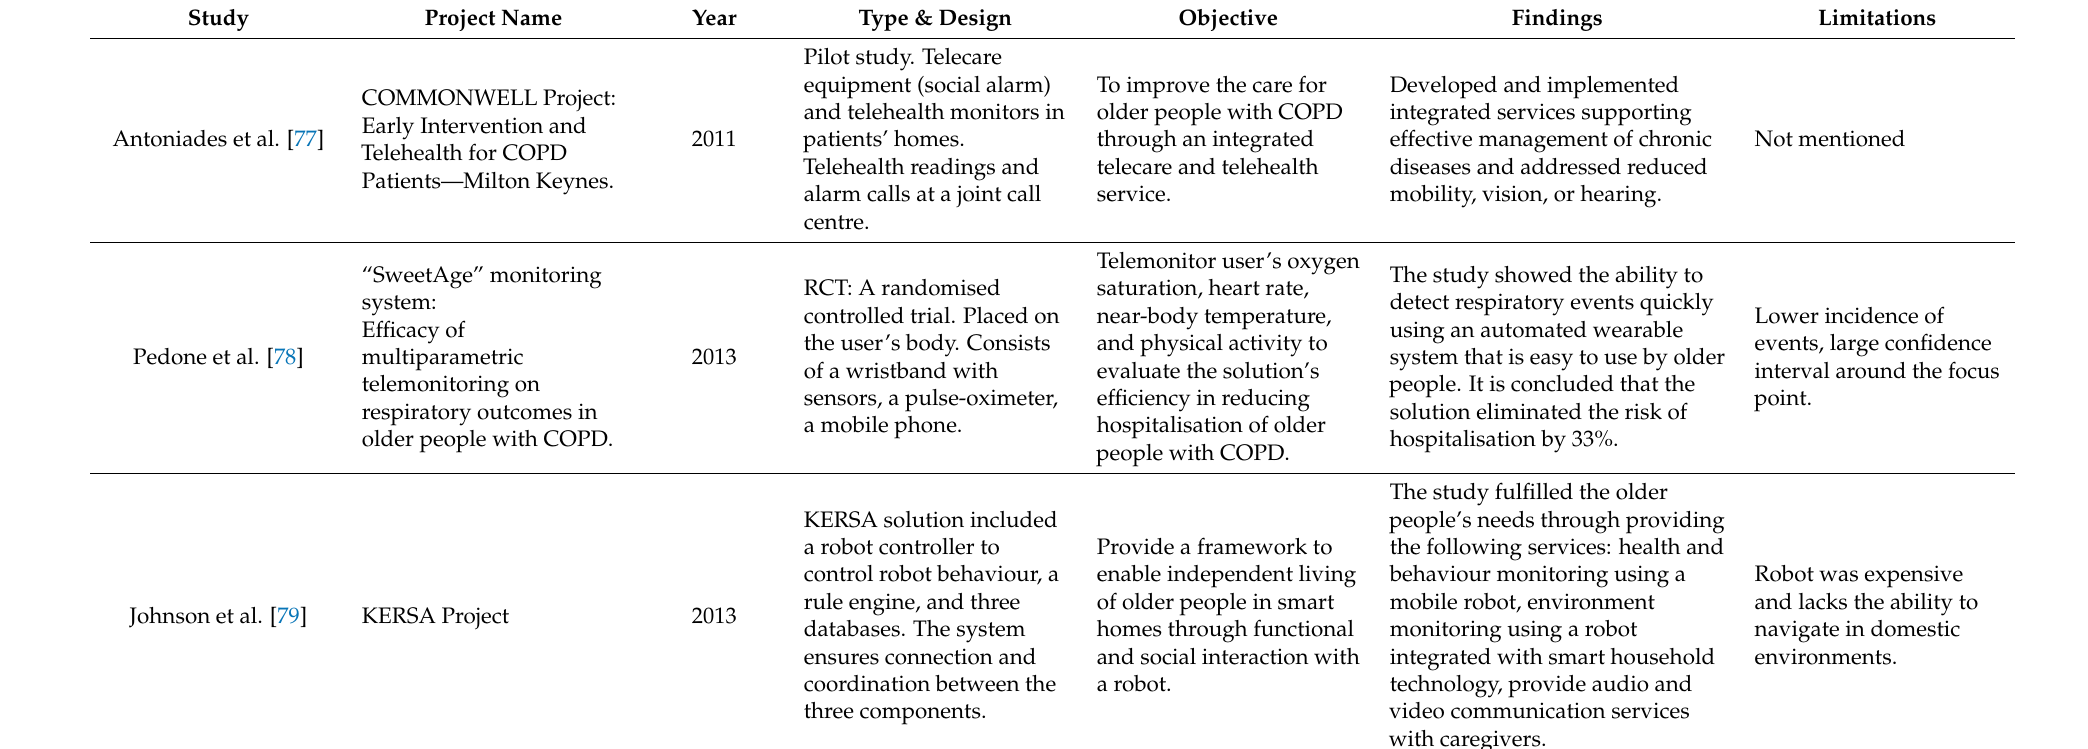
Table 2. ICT solutions for assistive living of older people with